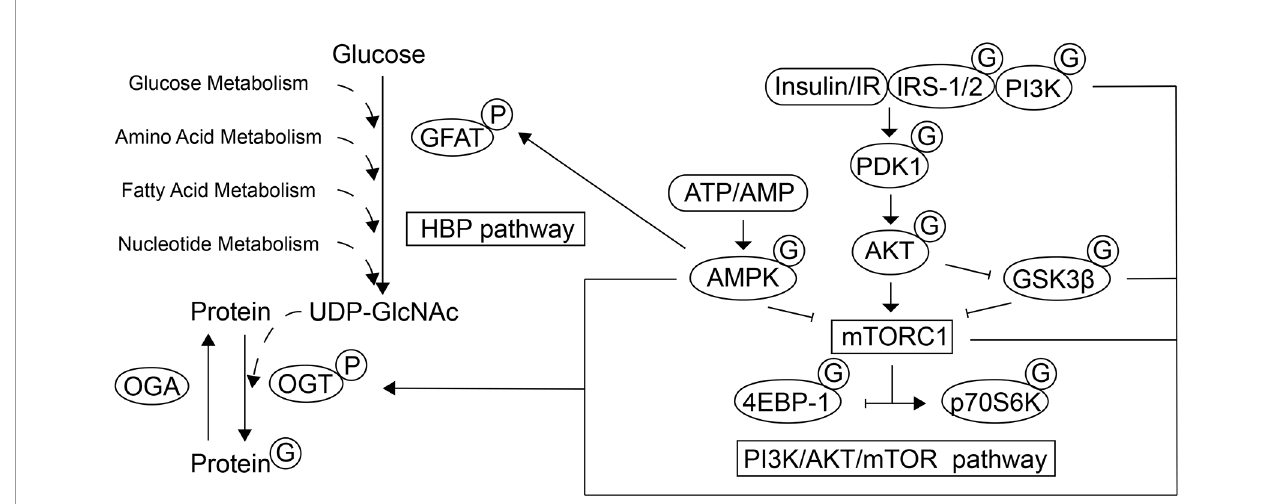
FIGURE 1 | Schematic representation of the interplay between the HBP, mTOR and AMPK pathways. O-GlcNAcylation, as a PTM of a wide variety of nuclear, cytoplasmic, and mitochondrial proteins, participates in various cellular processes. The HBP integrates glucose, fatty acid, amino acid, and nucleotide metabolism to generate the substrate for O-GlcNAcylation, UDP-GlcNAc. GFAT is the rate-limiting step of the HBP and its activity can be regulated by AMPK through phosphorylation. The O-GlcNAc moiety can be transferred to the target proteins and removed by OGT and OGA, respectively. The activity of mTOR and GSK3 b can be mediated by the PI3K/AKT signaling pathway and mTORC1 promotes protein synthesis by directly phosphorylating 4E-BP1 and p70S6K. In response to energy state, AMPK also regulates the mTORC1 activity. The localization, activity, and substrate speci fi city of OGT are regulated through phosphorylation by AMPK, IR/PI3K and GSK3 b , and the mTOR signaling regulates the expression of OGT. In contrast, several actors of the PI3K/AKT/mTOR signaling pathway have been found to be modi fi ed by O-GlcNAcylation, which leads to subsequent biological effects under different physiological